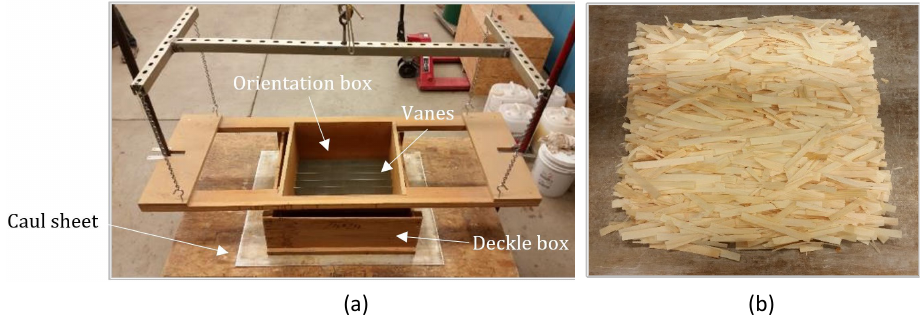
Figure 1. ( a ) Setup to fabricate a wood strand preform and ( b ) a typical wood strand preform prior to hot-pressing.